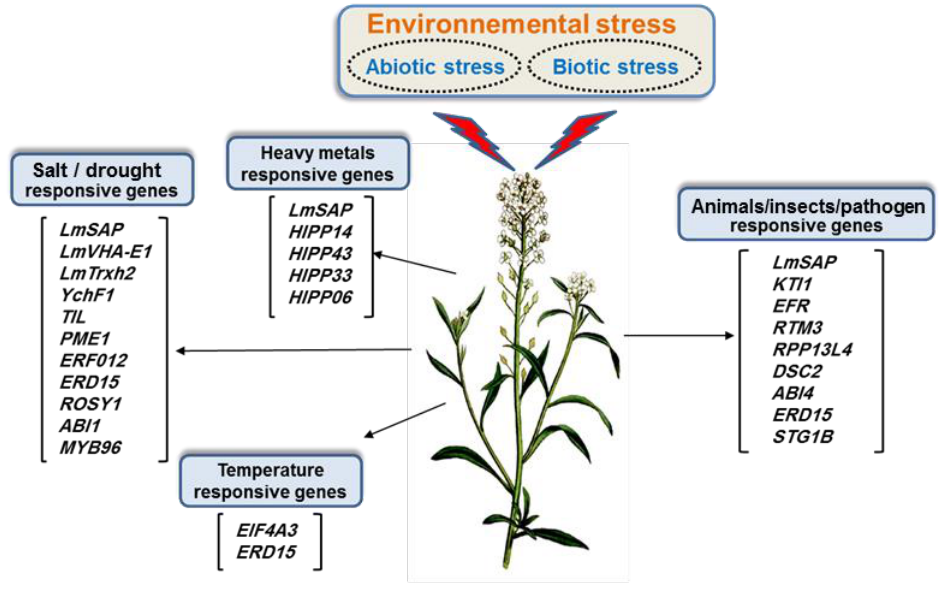
Figure 2. Environmental stress factors and main genes involved in adaptation and response in Lobularia maritima . Abbreviations: LmSAP : stress-associated protein; LmVHA-E1 : vacuolar H+ -ATPase subunit E1; LmTrxh2 : h-type Trx protein; ABI : ABA insensitive; EFR : EF-TU receptor; EIF : eukaryotic initiation factor; ERD : early responsive to dehydration stress; ERF : ethylene-responsive factor; HIPP : heavy-metal-associated isoprenylated plant protein; KTI : Kunitz trypsin inhibitor; MYB : myeloblastosis oncogene; PME : pectin methyl esterase; ROSY: interactor of synaptotagmin; RPP : resistance to P. pachyrhizi ; RTM : restricted tobacco etches virus movement; TIL : temperature-induced lipocalin; DSC2 : desmocollin-2.